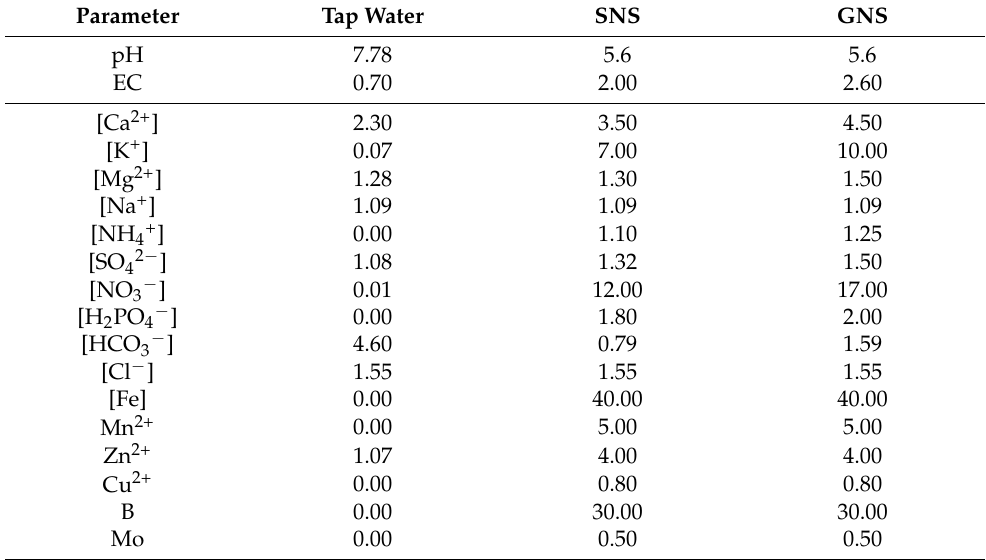
Table 2. pH, electrical conductivity (EC; dS m − 1 ), macronutrient (K, Ca, Mg, N, S, P; mM) and micronutrient (Fe, Mn, Zn, Cu, B, Mo; µ M) concentrations in the tap water, in the starter (SNS) and in the growth nutrient solution